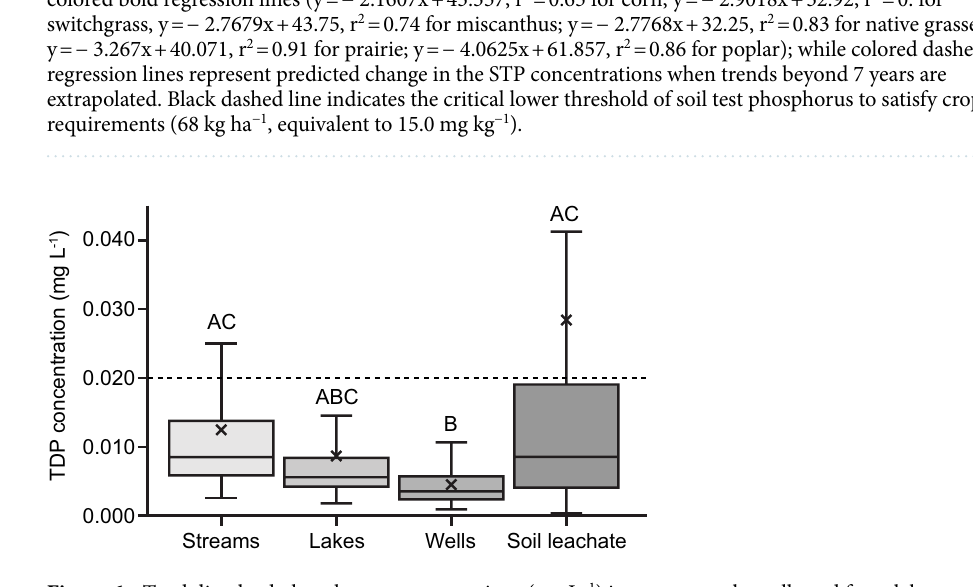
Figure 6. Total dissolved phosphorus concentrations (mg L −1 ) in water samples collected from lakes, streams, and groundwater wells compared to total dissolved phosphorus (TDP) concentrations in soil leachate sampled from different cropping systems. TDP was measured from 2009–2016 in lakes (n = 597), streams (n = 283), wells (n = 33), and soil water leachates (this study; n = 899). Horizontal lines within each box indicate the median while the asterisk show the mean. The upper and lower ends of the boxes denote the 25th and 75th percentiles, while the whiskers indicate 10th and 90th percentiles. Dashed line indicates the total P concentration above which surface waters are prone to eutrophication 3,16 When combination of water bodies shares a similar letter, the means grouped across years are not significantly different as determined by the Tukey honest significant differences post-hoc test (α = 0.05). The Tukey–Kramer method was used to make pairwise comparisons among groups because of the unequal sample